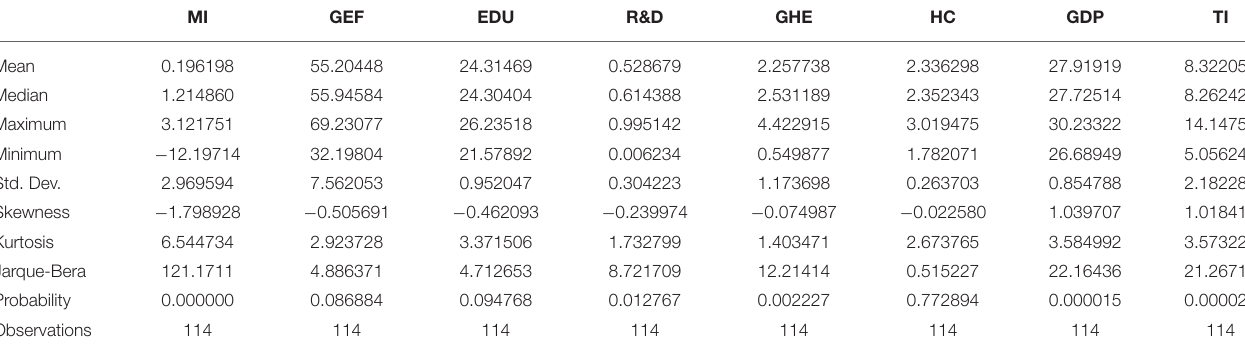
TABLE 3 | Descriptive statistics and normality